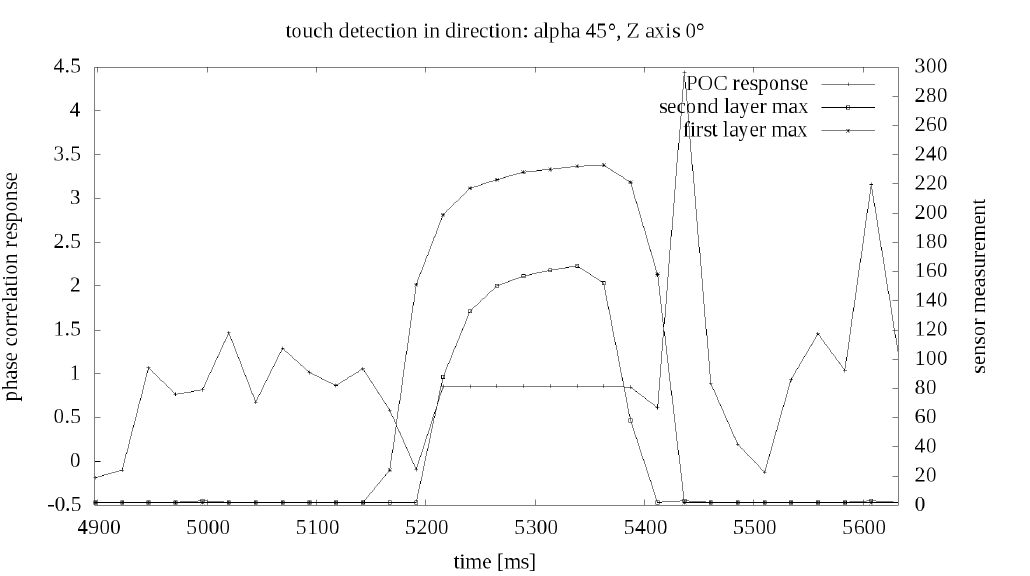
Figure 9. Example touch measurement in time.